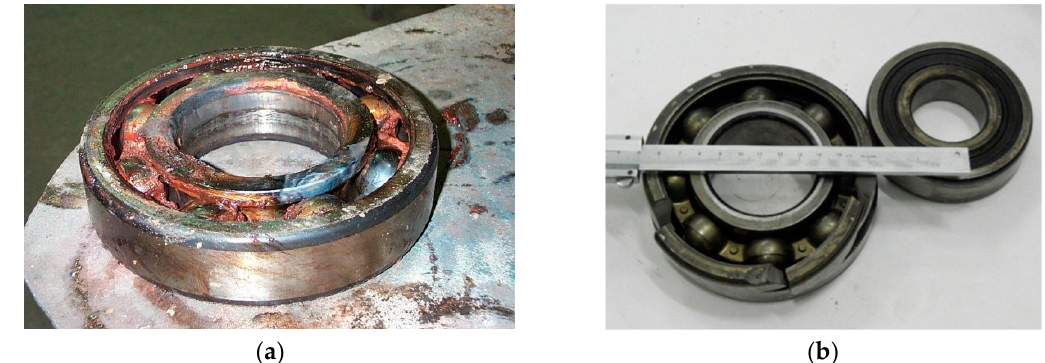
Figure 3. Rolling bearing as-received ( a ) and after the removal of organic residuals ( b ).